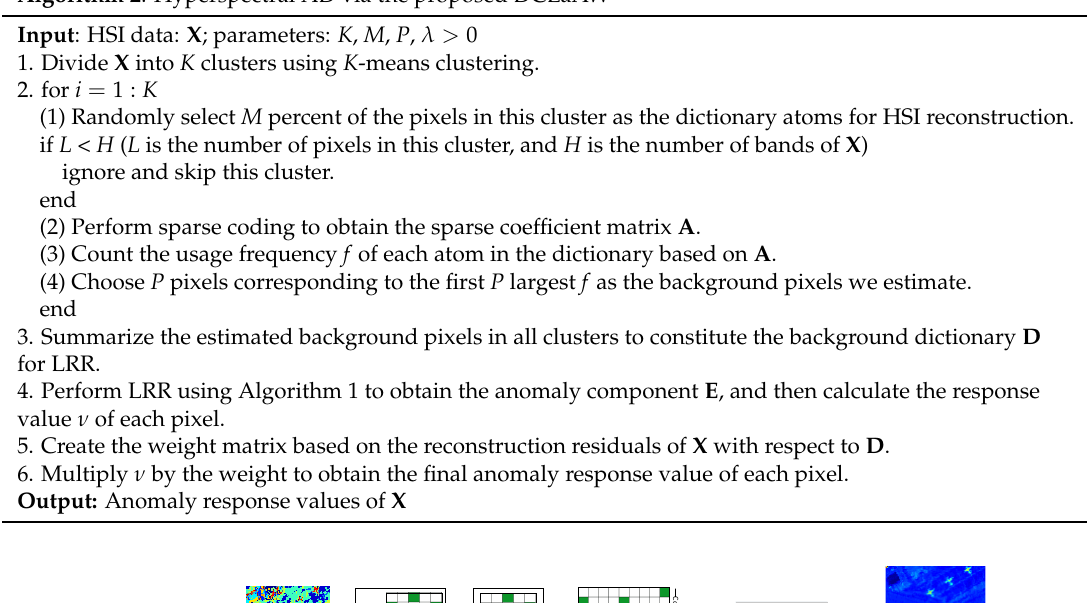
Algorithm 2 . Hyperspectral AD via the proposed DCLaAW